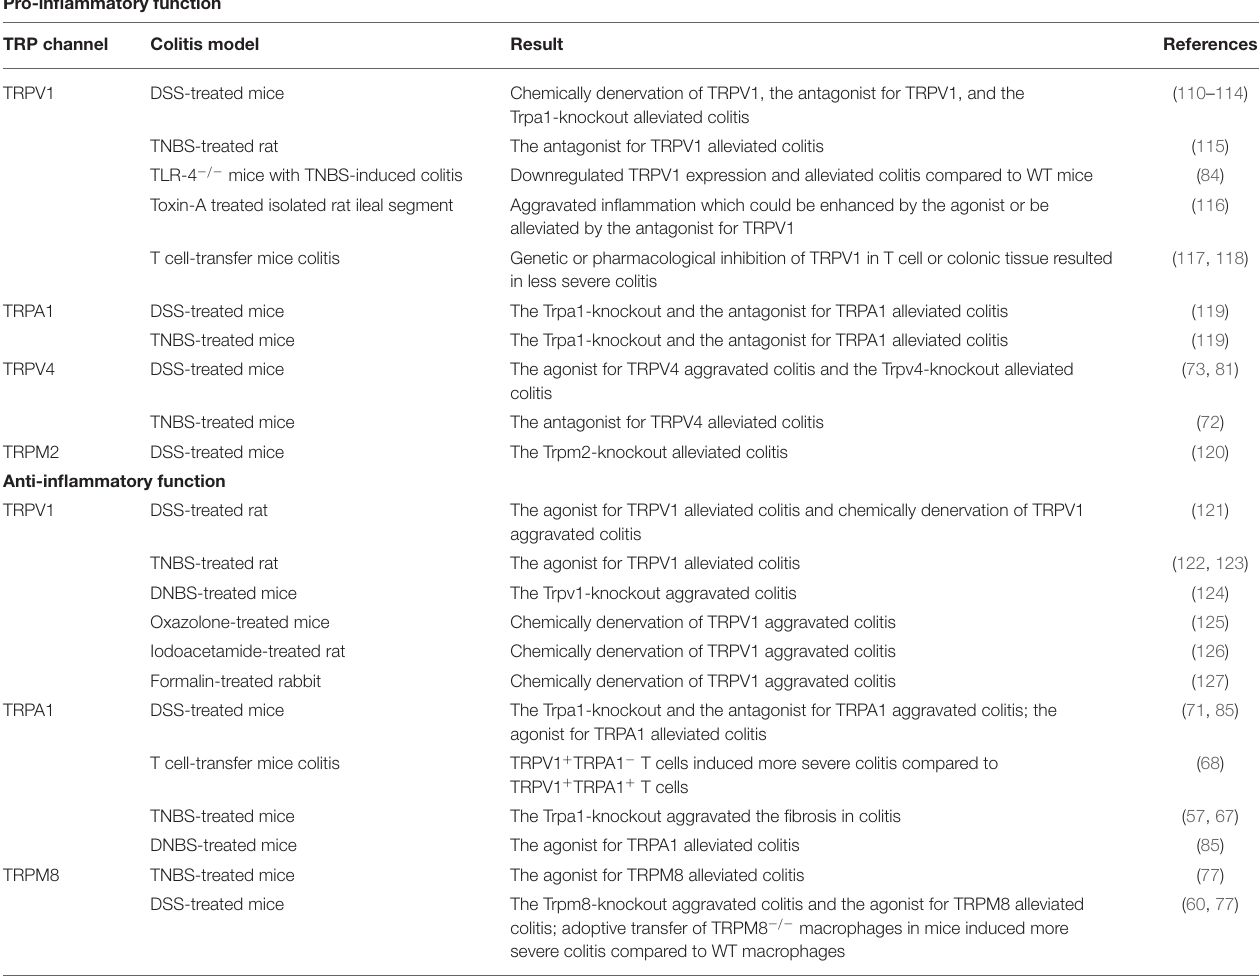
TABLE 3 | The function of TRP channels in pathophysiology of colitis models. Pro-inflammatory